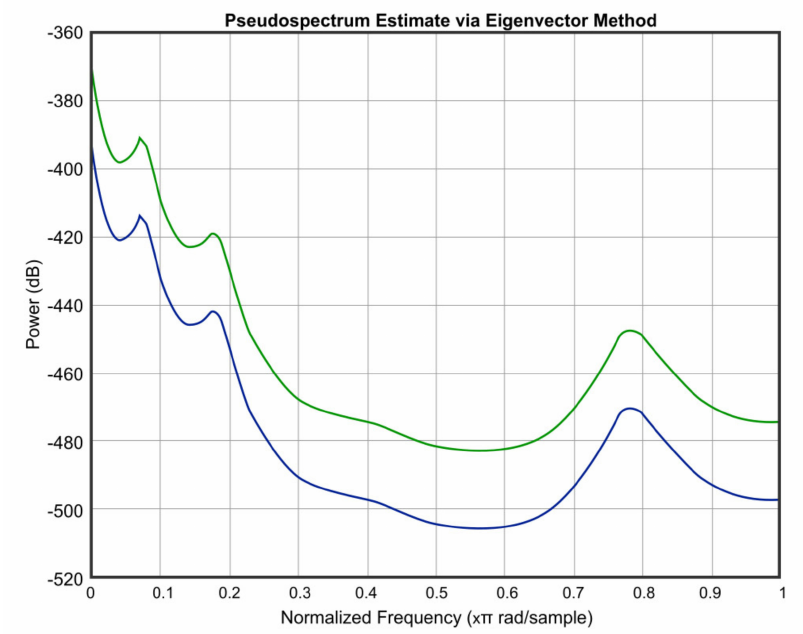
Figure 14. Signal behavior at T = 0 ◦ C and RH = 0% (blue) compared to T = 20 ◦ C and RH = 20% (green).